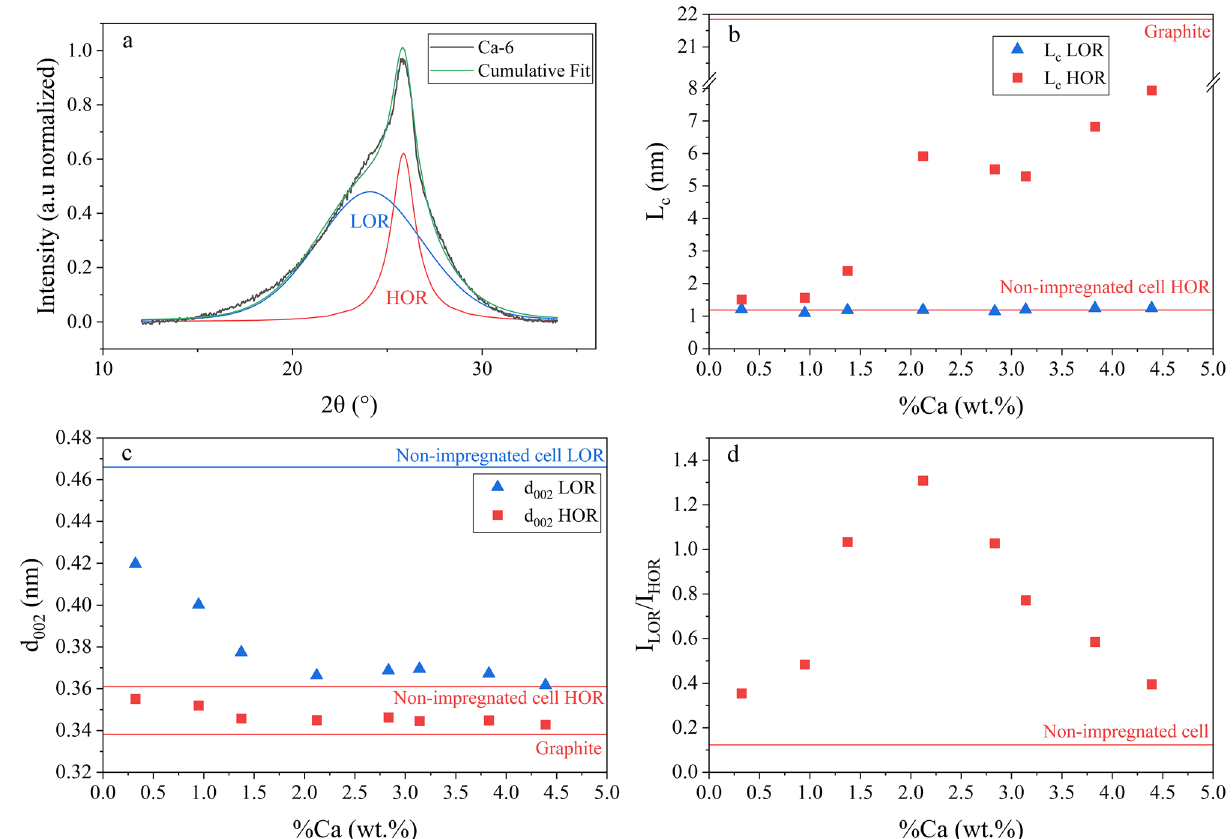
Figure 2. ( a ) Deconvolution of the XRD 002 peak of Ca-6 samples. ( b ) L c of LOR and HOR as a function of %Ca. ( c ) d 002 of LOR and HOR as a function of %Ca. ( d ) I LOR /I HOR as a function of